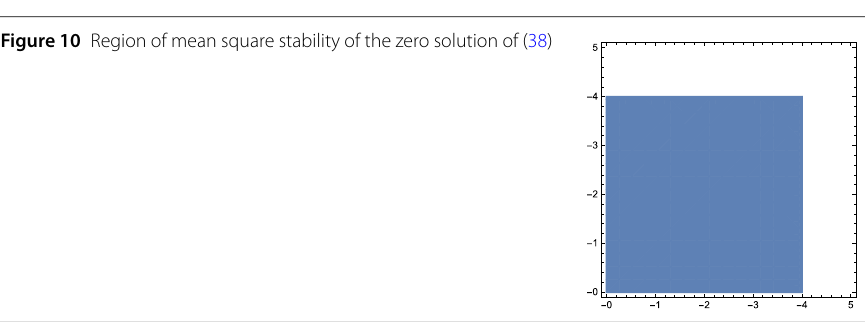
Figure 10 Region of mean square stability of the zero solution of